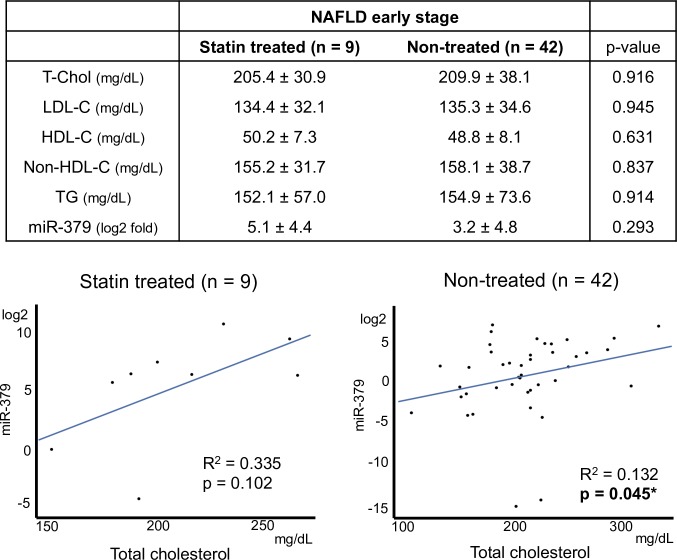
Statin treatment and serum miR-379 expression, and correlation with cholesterol levels.Value data are expressed as the mean ± standard deviation. R2: coefficient of determination. *p < 0.05.